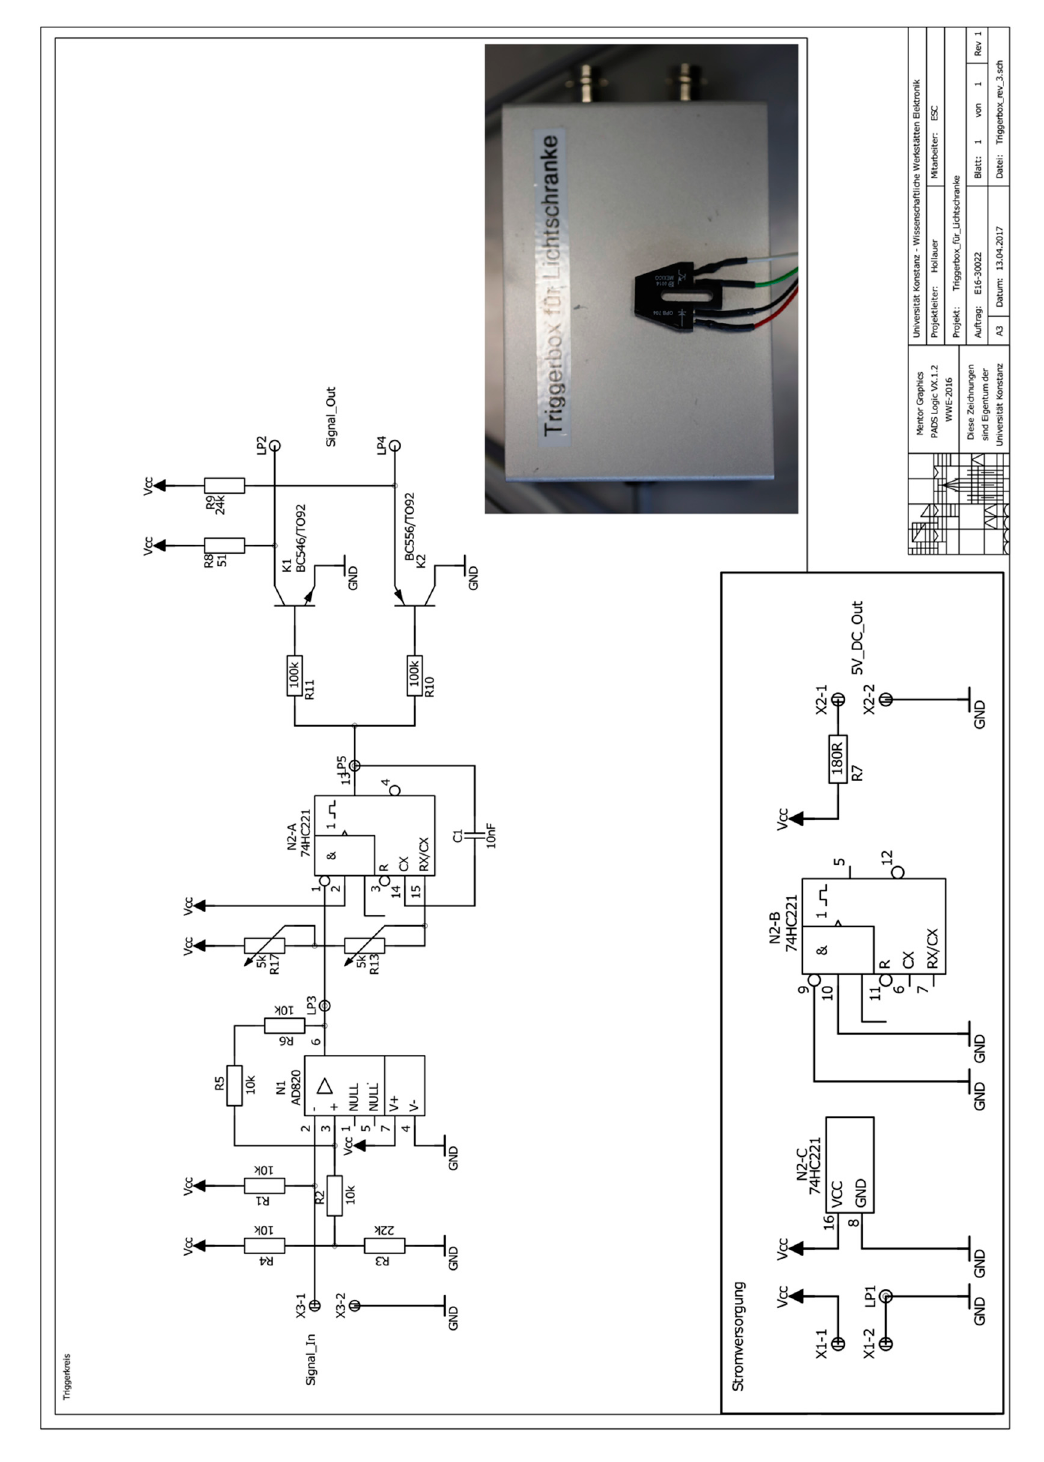
Figure A1. Electrical Schematic of reflective optical sensor and triggering electronics developed by the Universität Konstanz Electronics